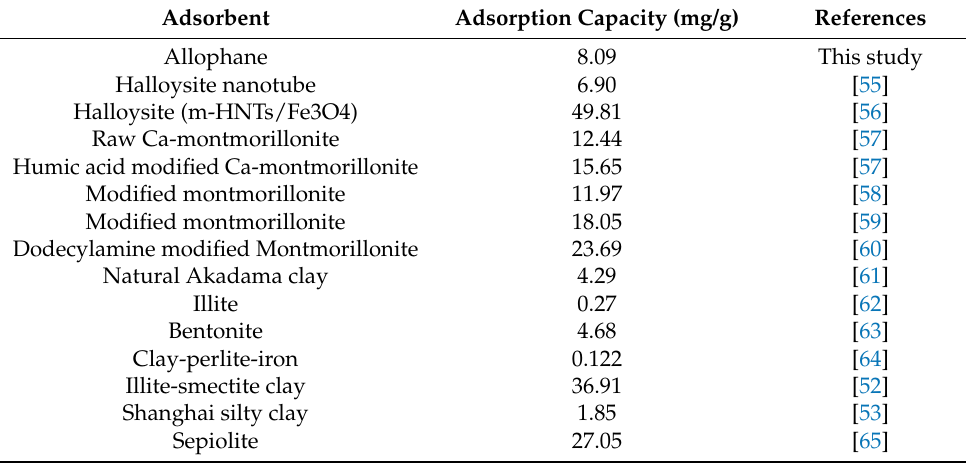
Table 4. Adsorption capacity of various clay materials towards